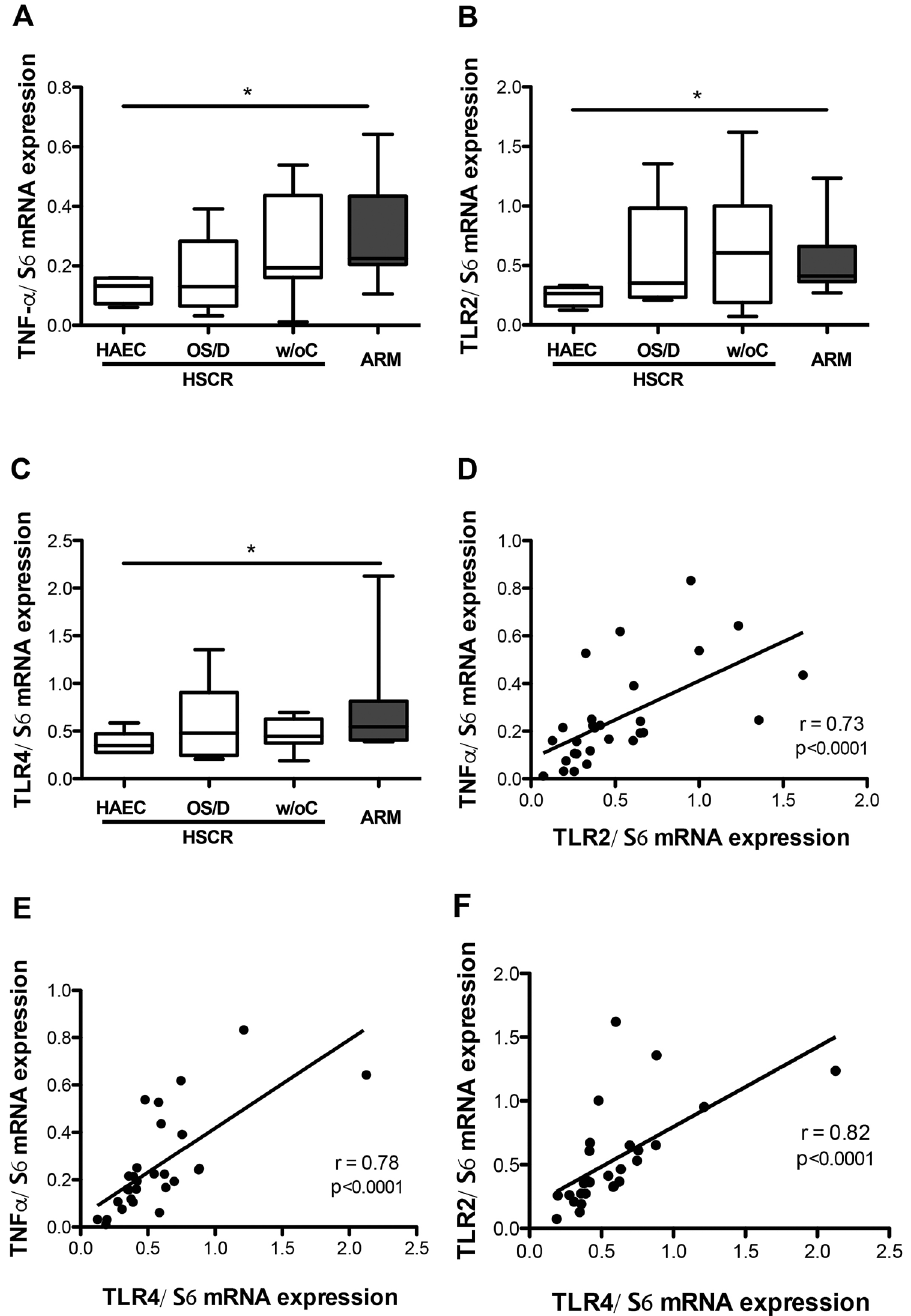
Figure 5. Expression of ( A ) TNFα expression (* p = 0.02), ( B ) TLR2 expression (* p = 0.01), and ( C ) TLR4 expression (* p = 0.02) in qPCR in the 3 HSCR subgroups (white bars) (HSCR patients with Hirschsprung- associated enterocolitis (HAEC), with obstructive symptoms or diarrhoea (OS/D) and without complications (w/oC)) and in ARM (grey bar) patients. Medians with ranges. ( D ) Correlation between TNFα and TLR2 expressions (r = 0.73; 95% IC 0.48–0.87; p < 0.0001), ( E ) between TNFα and TLR4 expressions (r = 0.78; 95% IC 0.56–0.89; p < 0.0001), and ( F ) between TLR4 and TLR2 expressions (r = 0.82; 95% IC 0.63–0.92; p <